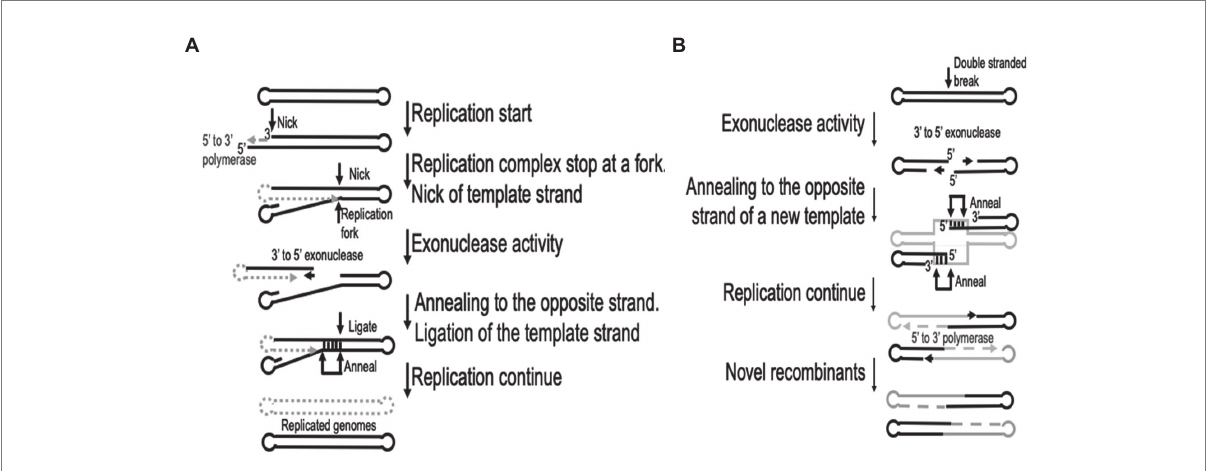
FIGURE 1 Graphical representation of the recombination processes involved in (A) . Replication fork repair and (B) double-stranded sequence break repair. This is based on the descriptions by Hamilton et al. (2007). Gray dotted lines represent new synthesis, while gray solid lines indicates a different virus genome in (B)